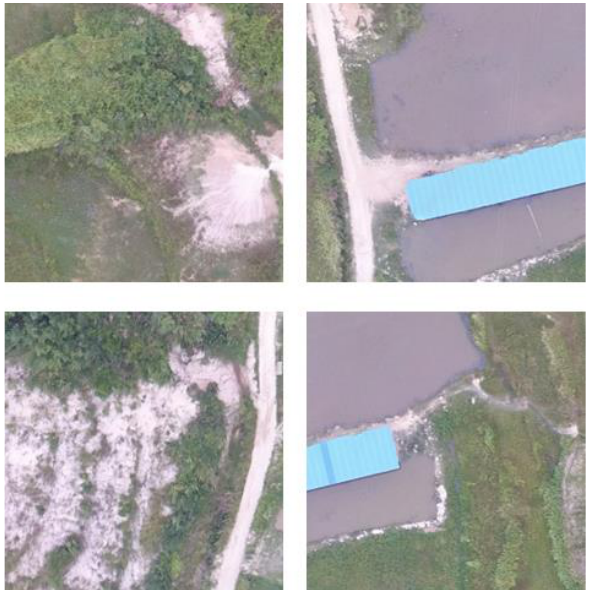
Figure 12. The top four